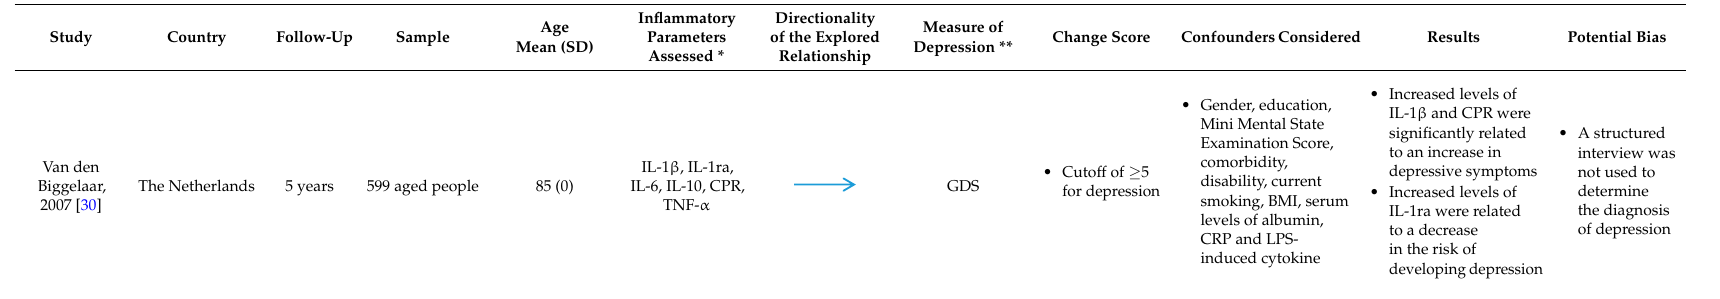
Table 1. Cont. Table 1. Main characteristics of cohort studies included in the